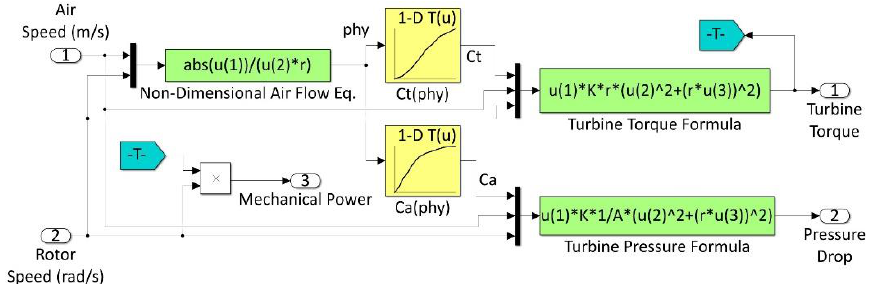
Figure 7. Simulink model of air turbine using the torque and the input coefficients.